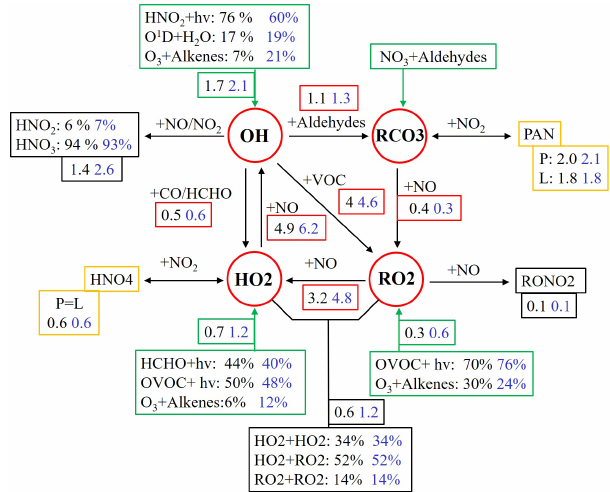
Figure 4. Comparison of the OH–HO 2 –RO 2 radical budget derived from the observed and PIC-VOCs under daytime conditions (07:00 to 19:00LT). The green, black, red, and yellow boxes denote the sources of radicals, radical sinks, radical propagation, and racial equilibrium, respectively. The numbers or percentages outside and inside the brackets are the average formation rates (ppbh − 1 ) or rela- tive contributions to a specific radical of the corresponding reaction path based on observed VOCs and PIC-VOCs,